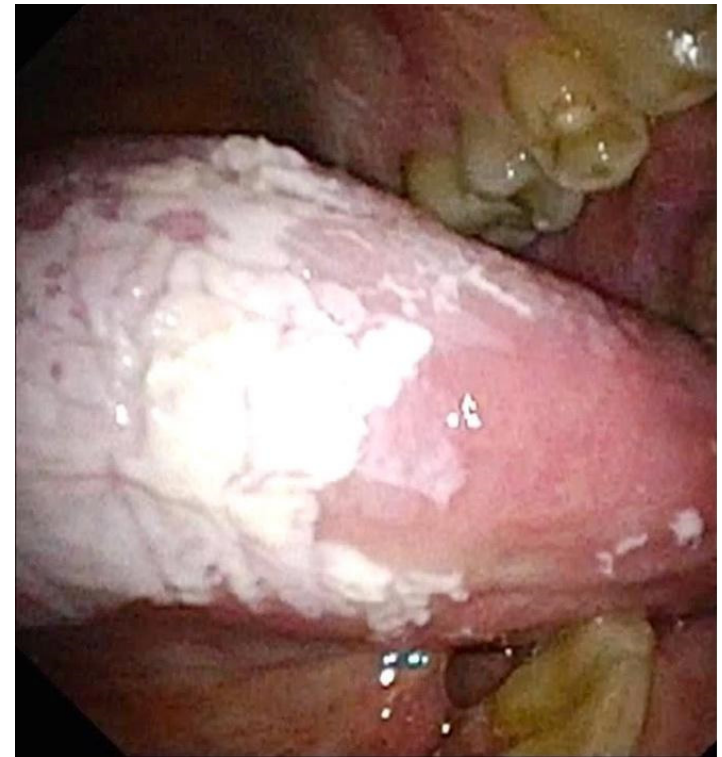
Figure 3. Leucoplakia of the tongue.